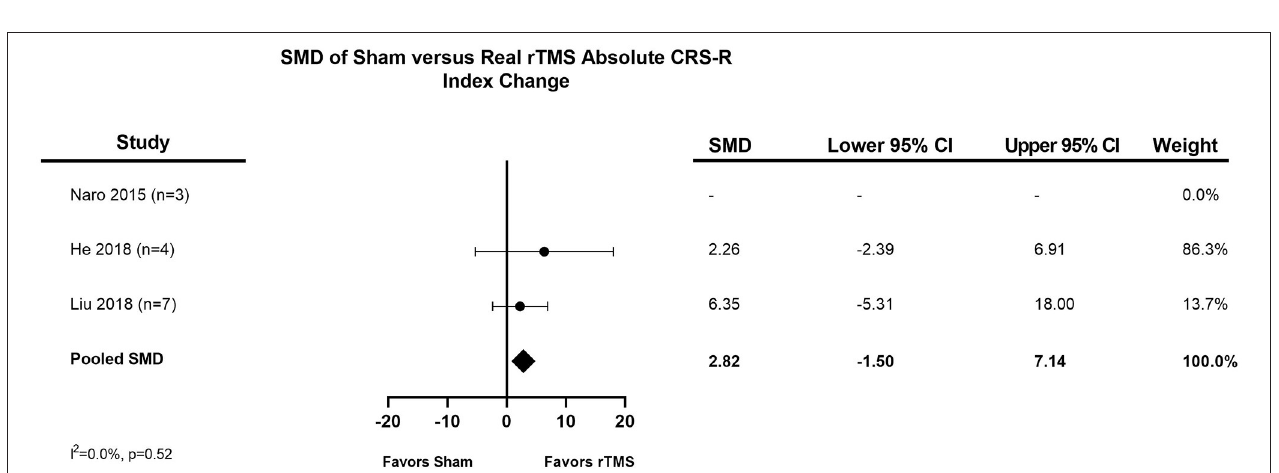
FIGURE 4 | Meta-analysis of IPD: difference in pooled mean absolute CRS-R index change from baseline to last post-TMS CRS-R assessment for real rTMS vs. sham TMS. A positive SMD (pooled mean absolute change toward the right of the figure) favors a positive effect for TMS, while a negative SMD (pooled mean absolute change toward the left of the figure) favors sham TMS. CI, Confidence Interval; CRS-R, Coma Recovery Scale-Revised; DoC, Disorder of Consciousness; SMD, standardized mean difference; TMS, Transcranial magnetic